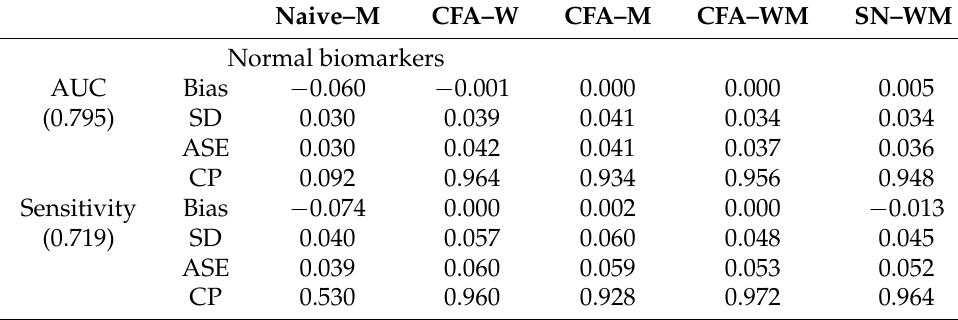
Table A2. Simulation study when σ u = σ v = 1.22